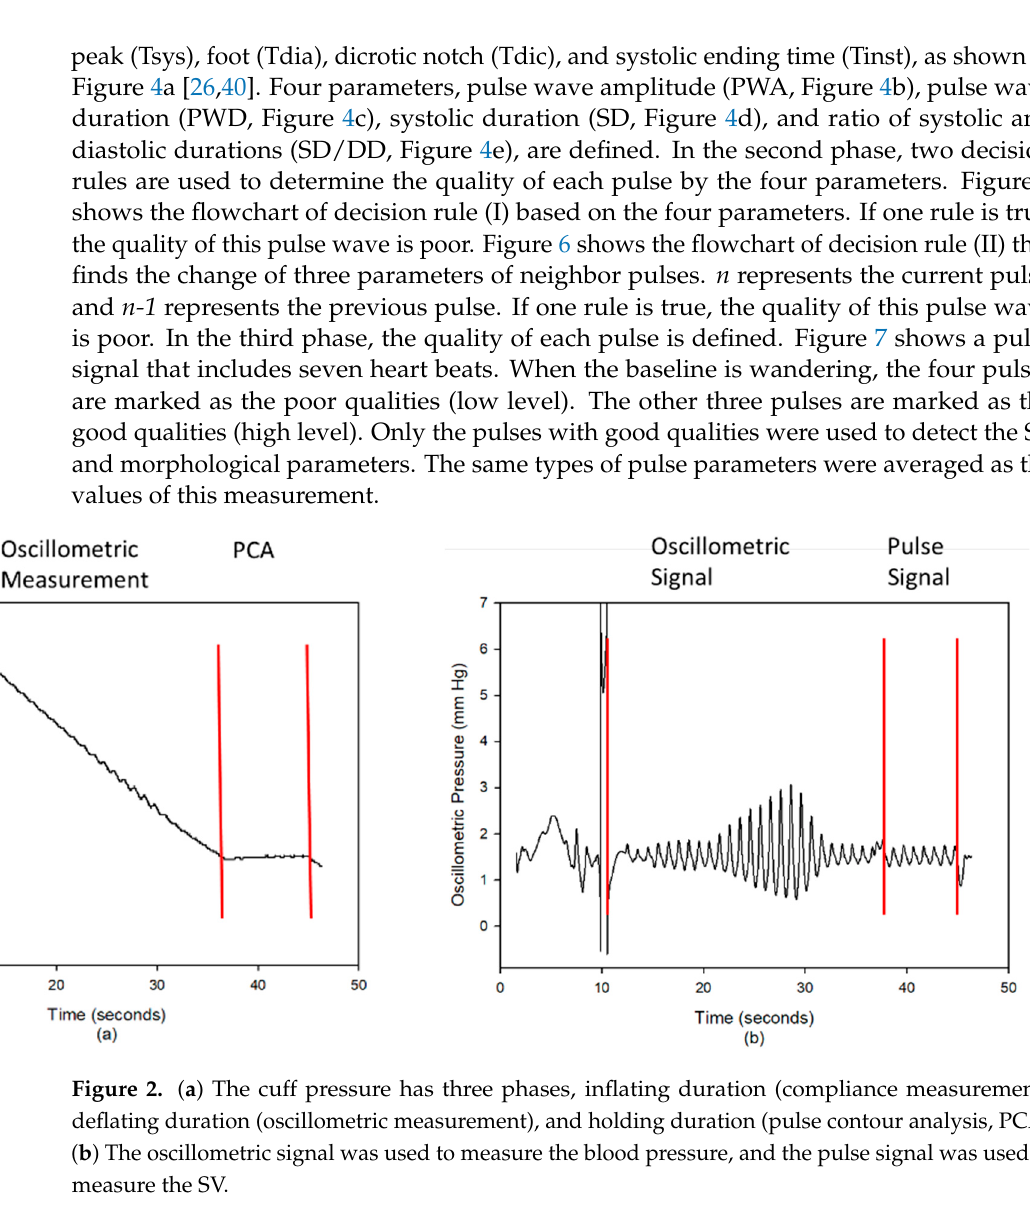
Figure 2. ( a ) The cuff pressure has three phases, inflating duration (compliance measurement), deflating duration (oscillometric measurement), and holding duration (pulse contour analysis, PCA). ( b ) The oscillometric signal was used to measure the blood pressure, and the pulse signal was used to measure the SV.